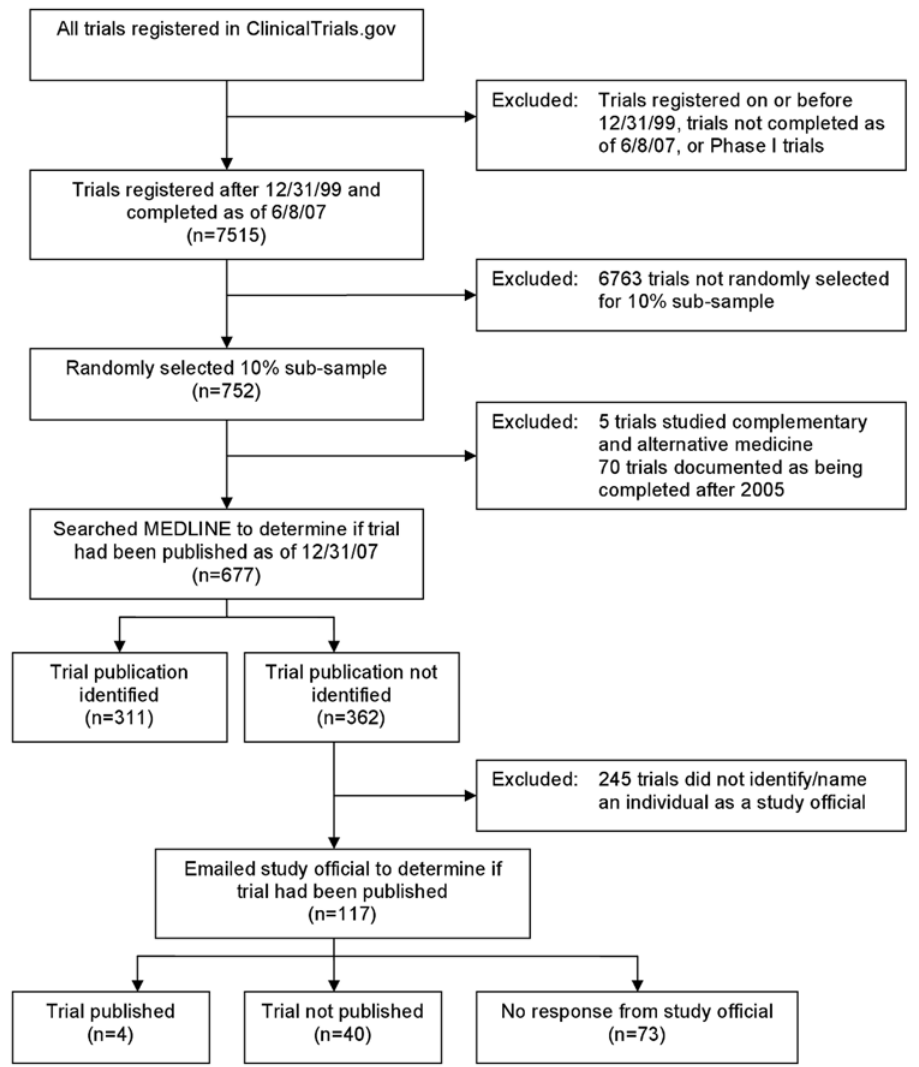
Figure 1. ClinicalTrials.gov trial inclusion flow chart.